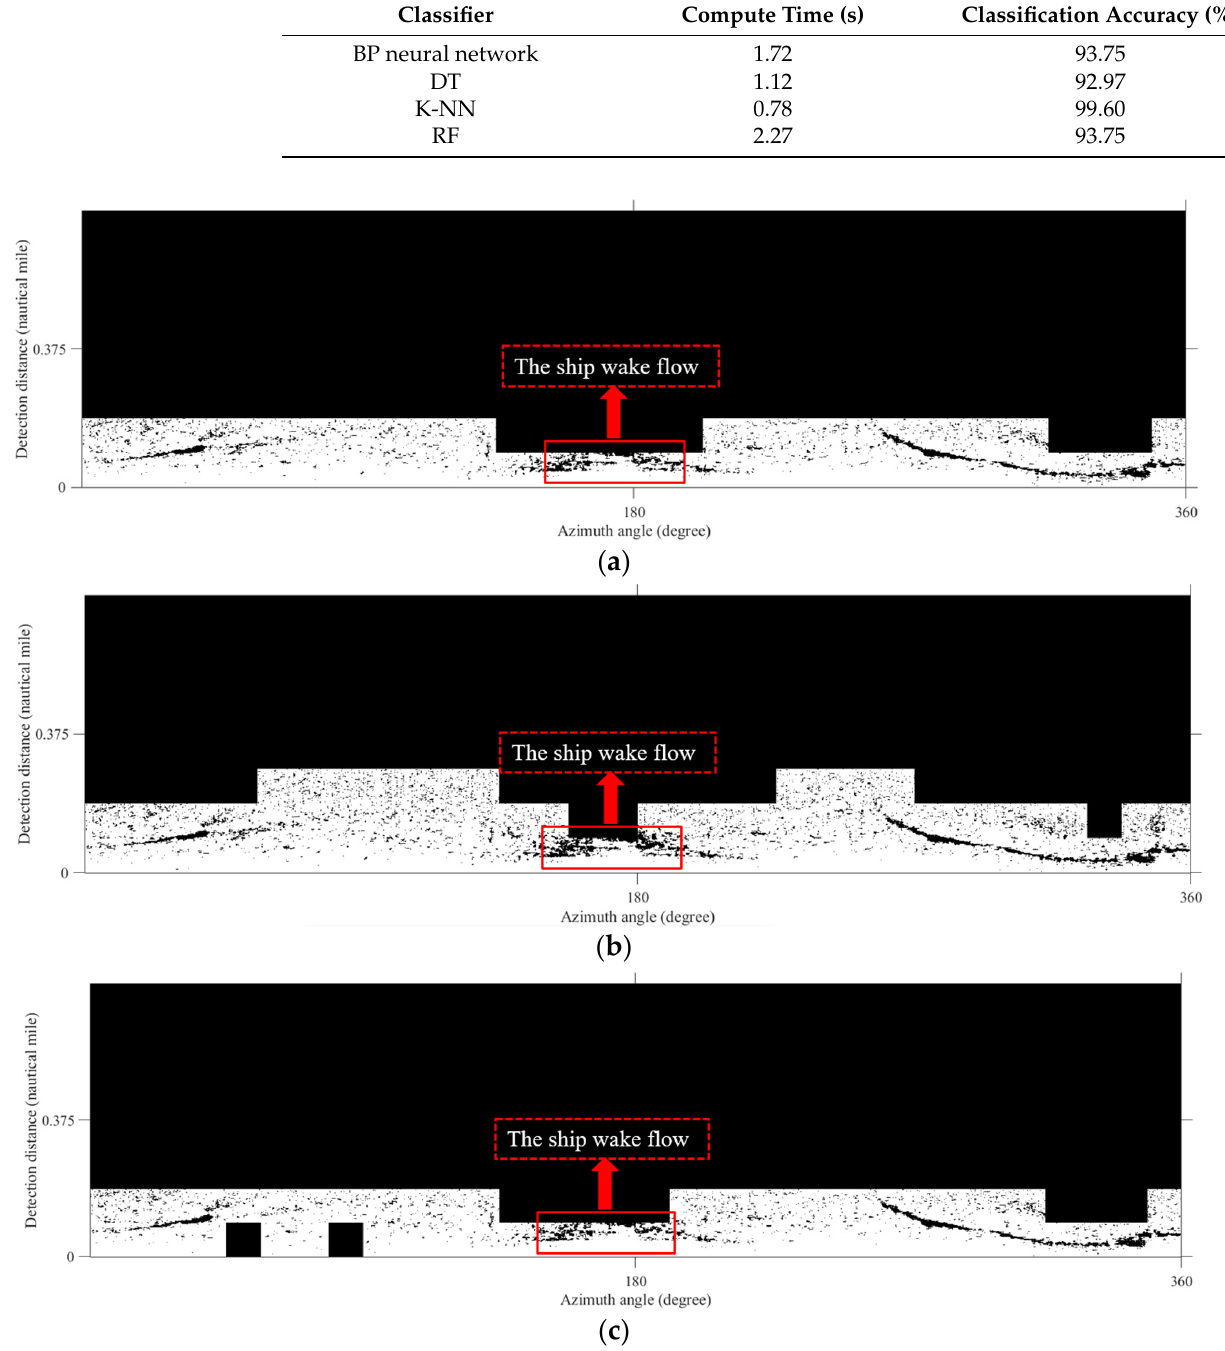
Figure 10. The results of Sauvola segmentation: ( a ) BP neural network; ( b ) K-Nearest Neighbor; ( c ) Decision Tree.